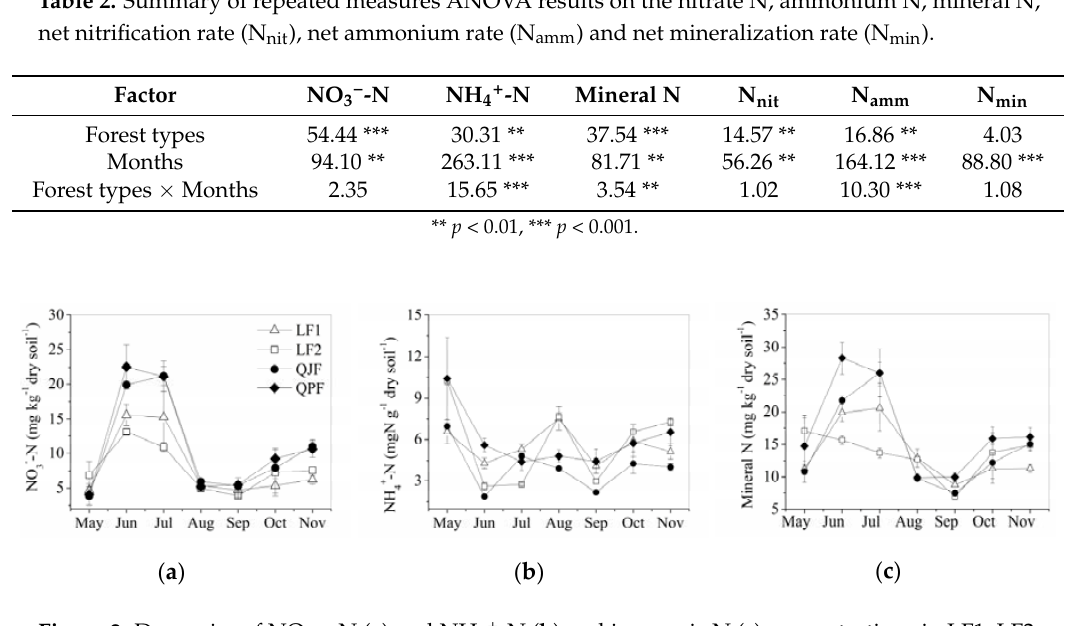
Table 2. Summary of repeated measures ANOVA results on the nitrate N, ammonium N, mineral N,